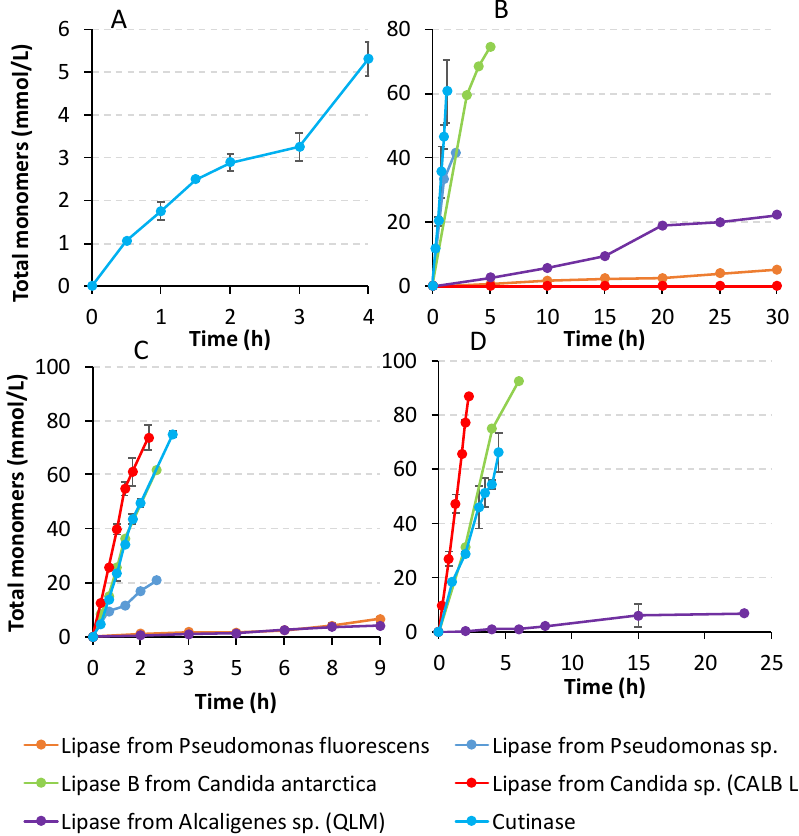
Figure 5. Concentration of the total monomers (mmol/L) detected via HPLC-RID analysis in the liquid fraction of PBS ( A ), PBSA ( B ), PCL6500D ( C ) and PCL6800D ( D ) degraded samples by the different enzymes over time (hours).